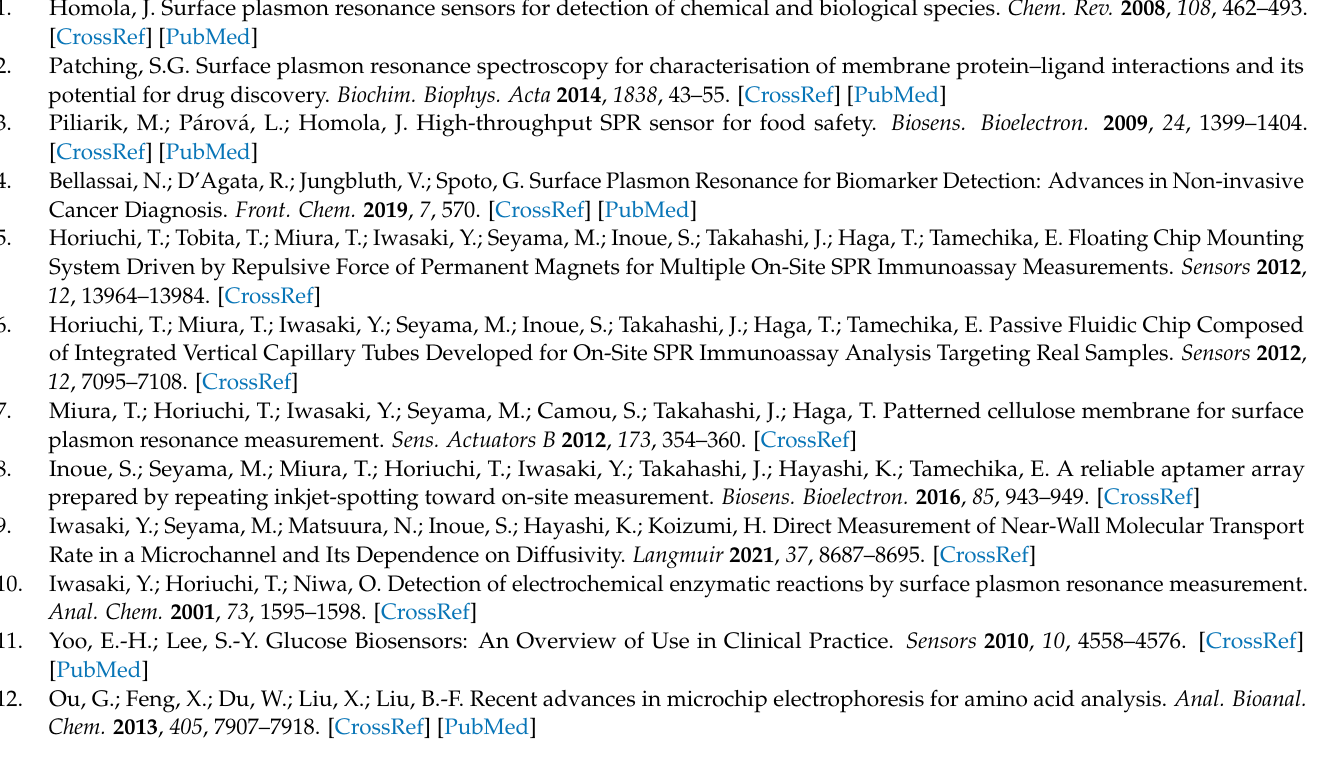
method.; Figure S5: The reproducibility of the EC-SPR measurements of glutamate